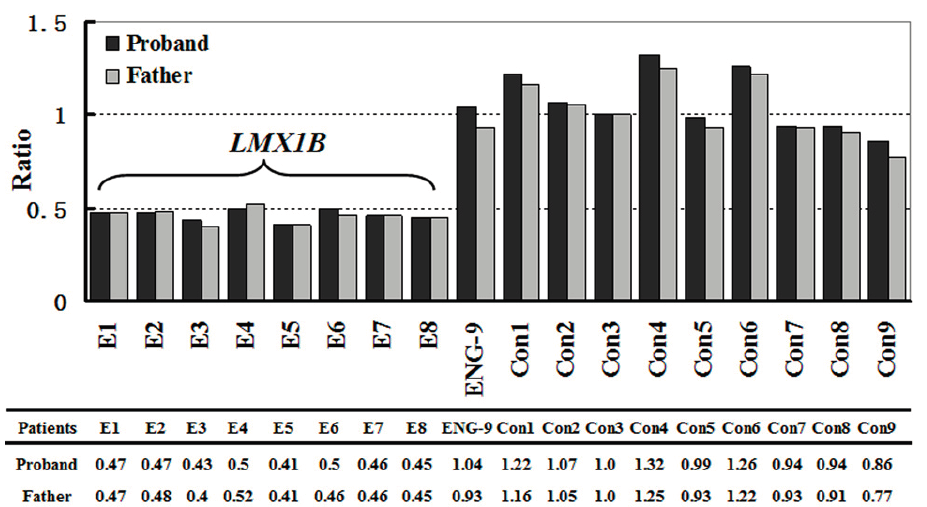
Figure 3. Results of MLPA analysis. A single-copy deletion of the entire LMX1B was detected in the proband and his